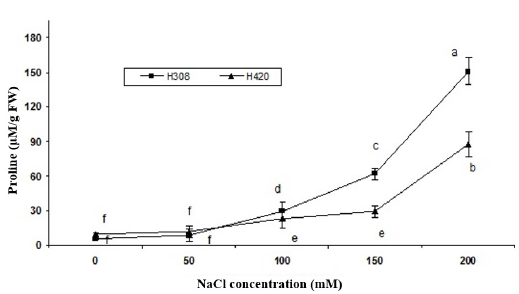
Fig. 4. The effect of various salt concentrations on the proline content in leaves of two canola genotypes (H420 and H308). Values are mean ± SE (n=3). Means followed by the same letter did not significantly differ at P ≤0.05 according to Duncan’s multiple range